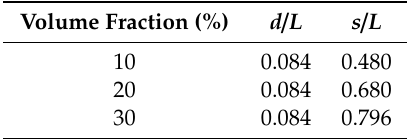
Table 3. Design data of multiple res-BCC xyz lattices.